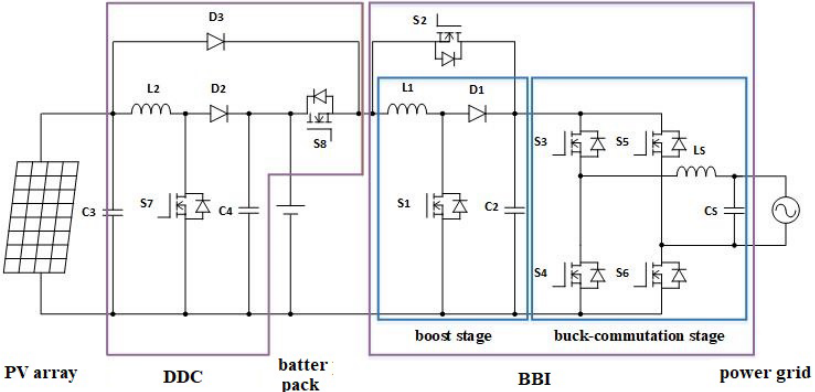
Figure 2. Power circuit of the proposed power conversion interface.